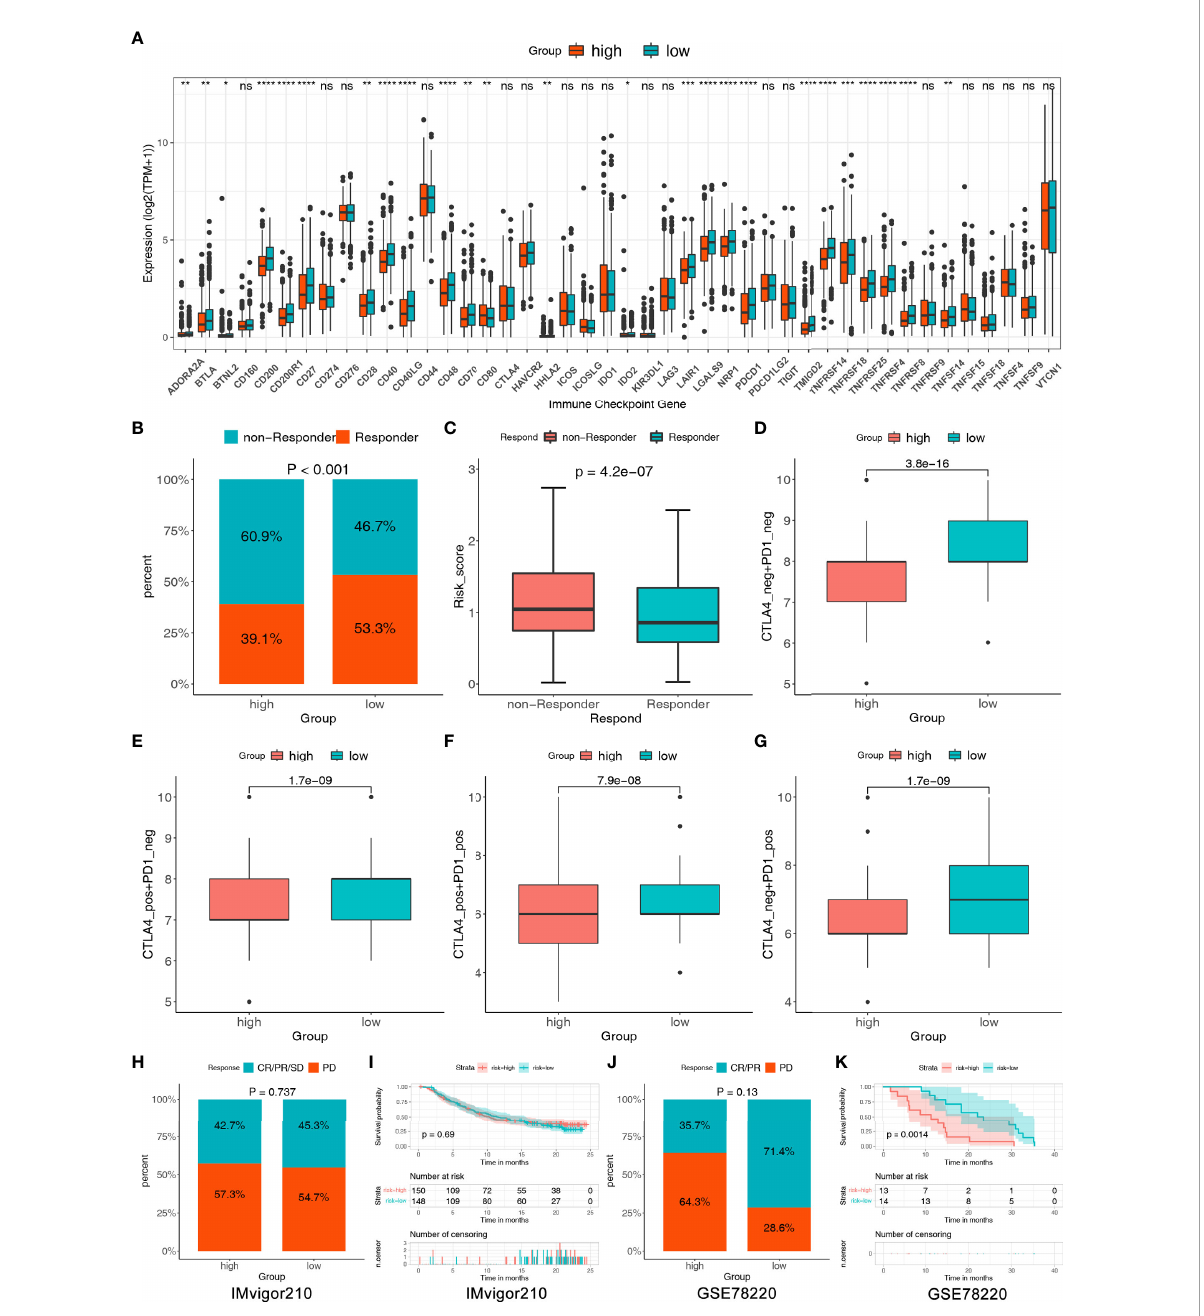
FIGURE 8 The assessment of immunotherapy response between the two risk groups. (A) Comparisons of the 44 ICGs in the two risk groups. (B) Comparisons of the proportions of non-responders and responders to ICIs between the two risk groups. (C) Differences in risk score between the responders and non-responders. (D – G) Differences in the IPS between the two risk groups strati fi ed by CTLA4 and PD-1. (H) The proportion of patients with response to anti-PD-1/L1 immunotherapy in patients with high or low risk score in IMvigor210 cohort. (I) Survival analyses for patients with high or low risk score in IMvigor210 cohort. (J) The proportion of patients with response to anti-PD-1/L1 immunotherapy in patients with high or low risk score in GSE78220 cohort. (K) Survival analyses for patients with high or low risk score in GSE78220 cohort. Statistical signi fi cance at the level of ns>0.05, * ≤ 0.05, ** ≤ 0.01, *** ≤ 0.001 and **** ≤